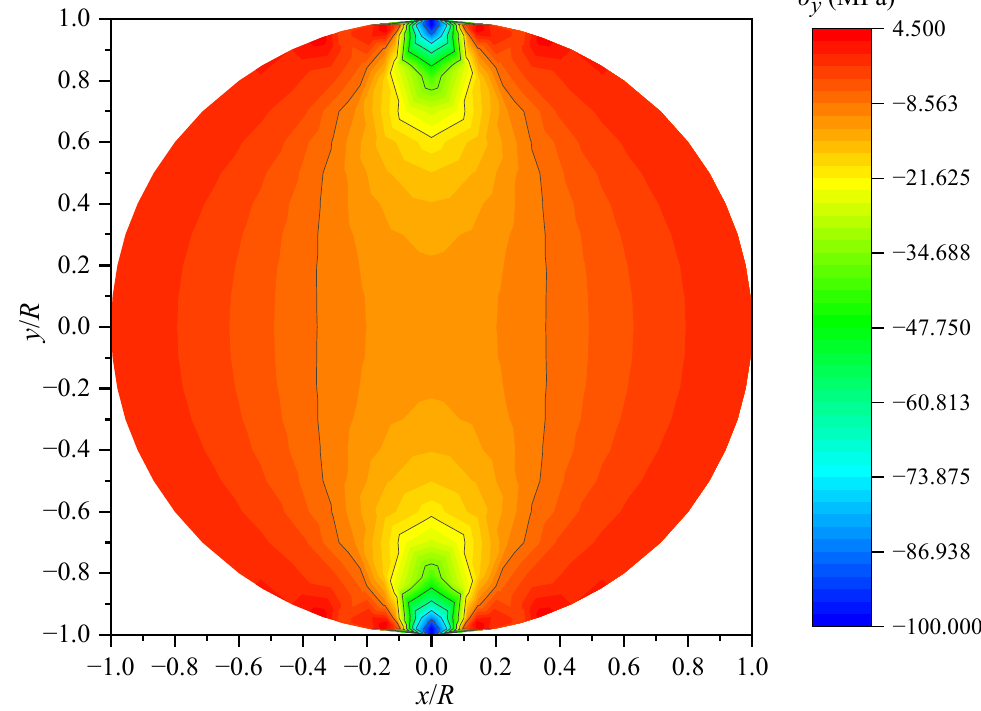
Figure 5. σ y contour map of the axial compression on the part boundary of the circular shaft.